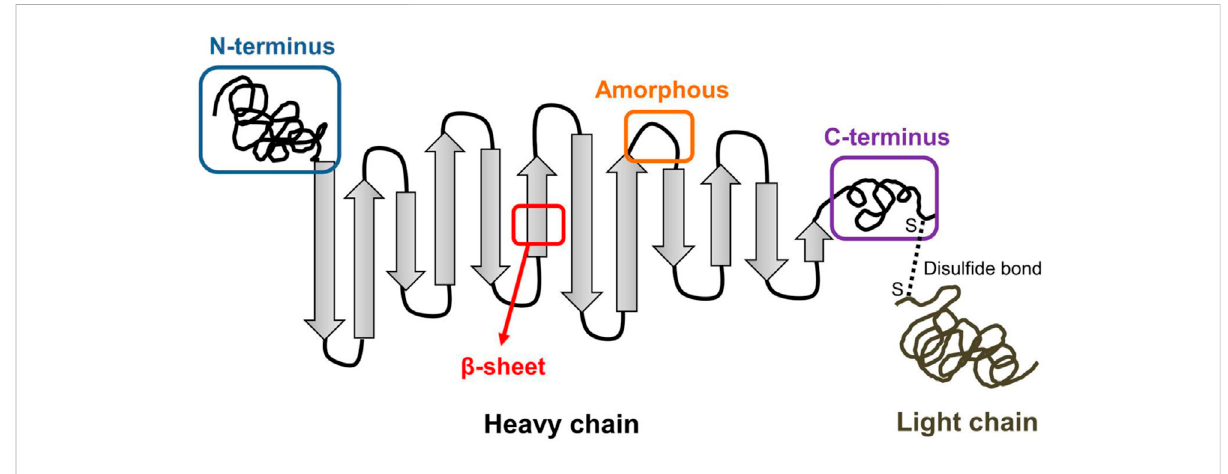
FIGURE 1 Illustration of SF structure including the heavy chain and light chain. (Wongpinyochit et al., 2018). Copyright 2018 American Chemical